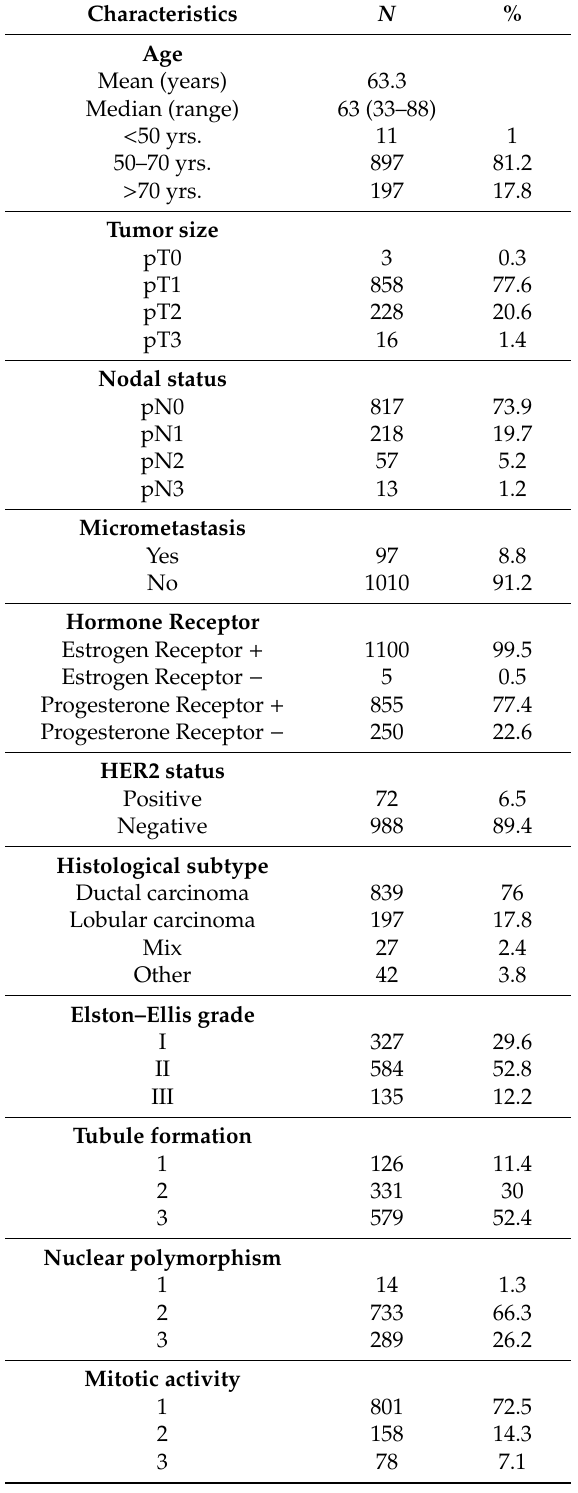
Table 1. Characteristics of the population ( n =